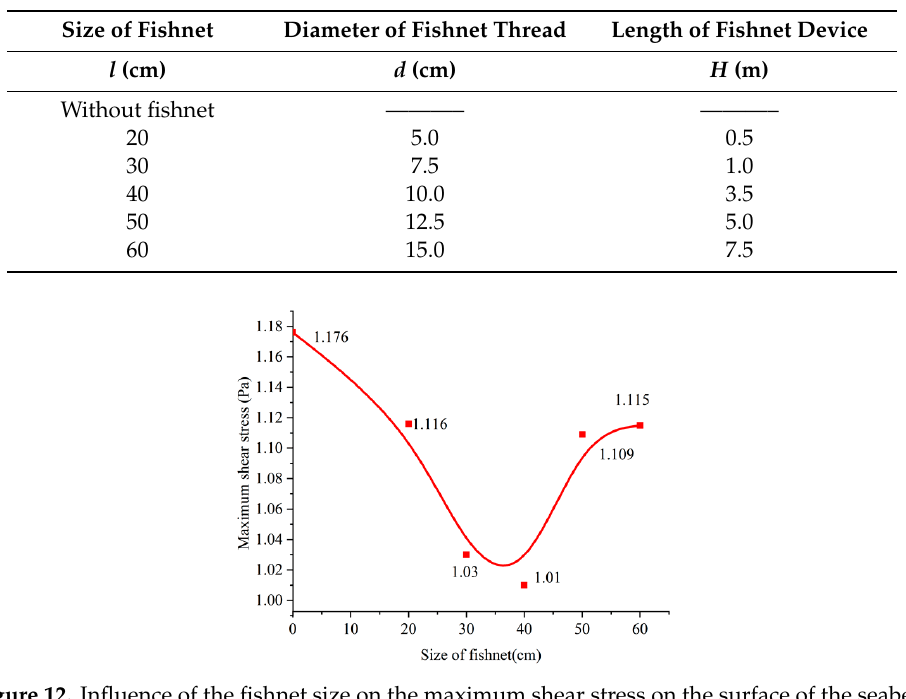
Figure 13. Influence of the fishnet thread diameter on the maximum shear stress on the surface of the seabed.